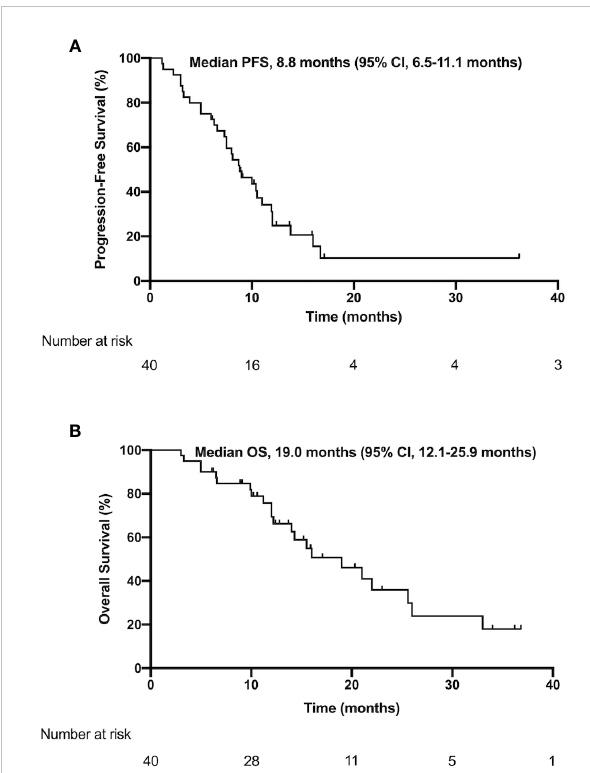
FIGURE 1 Kaplan – Meier estimates of PFS (A) and OS (B) in the patients with metastatic triple negative breast cancer who received anlotinib and chemotherapy. PFS, progression-free survival; OS, overall survival; CI, con fi dence interval.